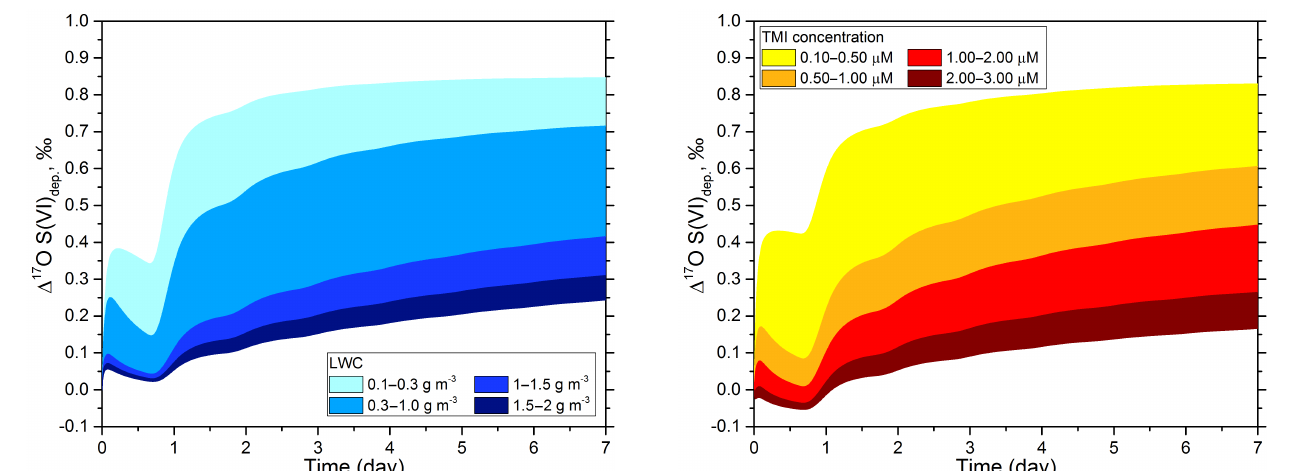
shows the evolution of (cid:49) 17 O(S ( VI ) , dep.) for varying LWC.